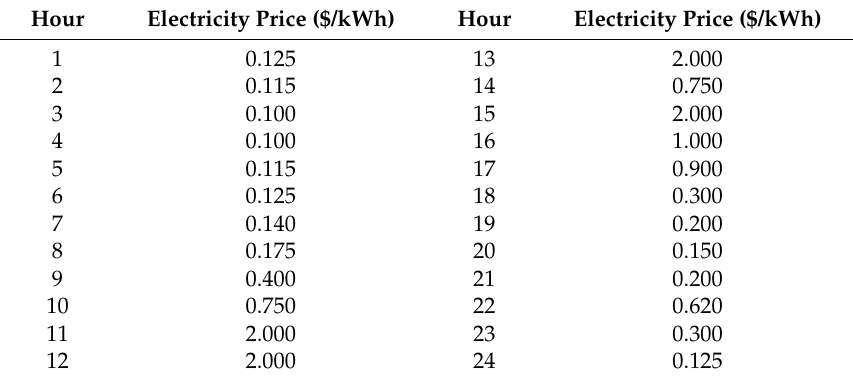
Table 5. Real-time market energy prices.